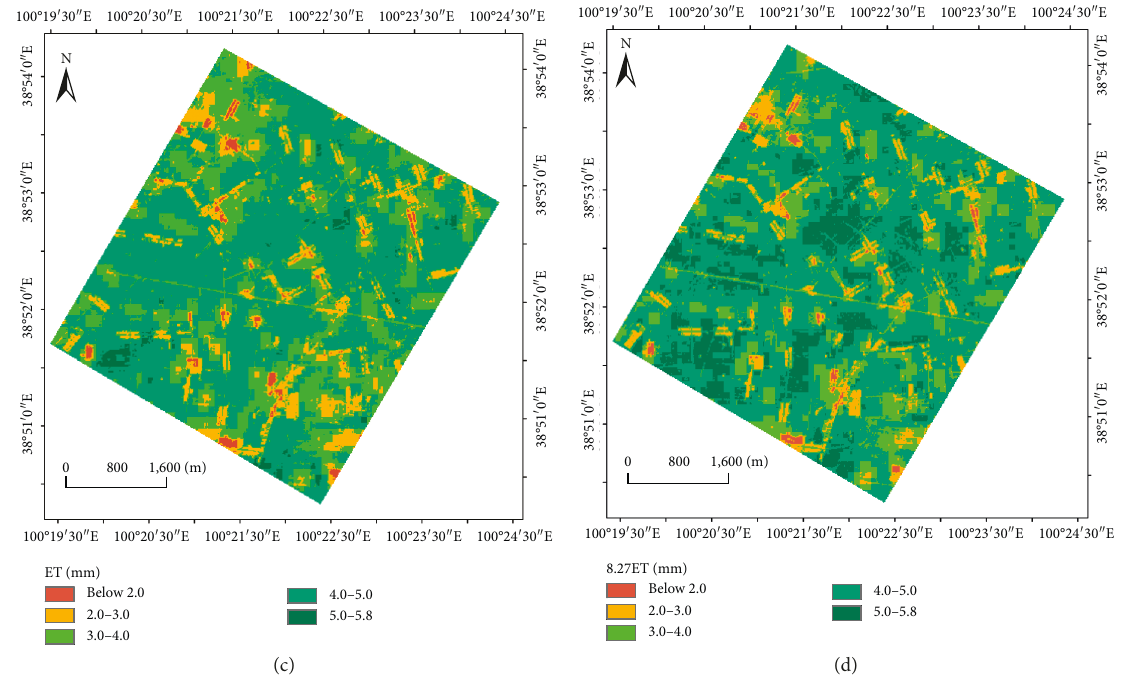
Figure 6: Daily ET calculated by the Gaussian fitting method on June 24 (a), July 10 (b), and August 11 (c) and 27 (d), 2012.